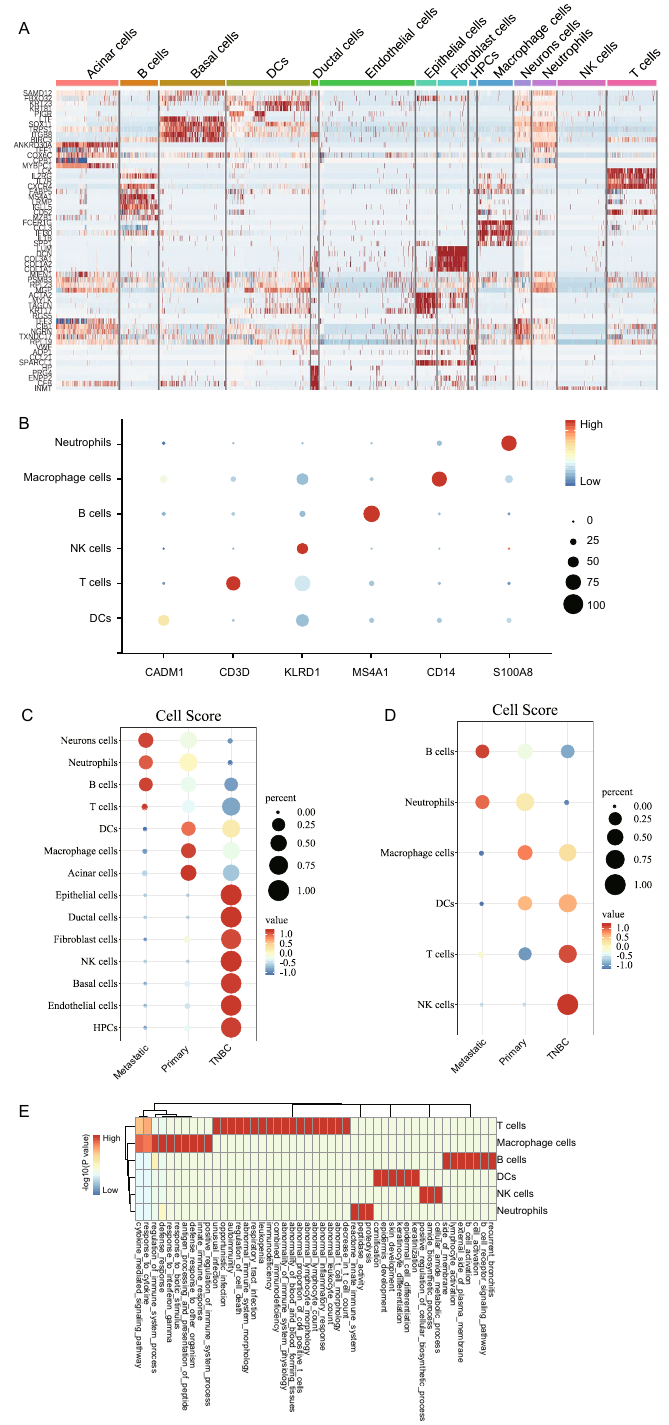
Figure 2. Differentially expressed genes, immune marker genes and cell ratio enrichment analysis. ( A ) The differential gene heat map of disparate cell types. ( B ) Analysis of immune marker gene expression. ( C ) Cell ratio enrichment analysis of 14 cell clusters. ( D ) Enrichment analysis of the immune cell ratio. ( E ) Functional annotation analysis of immune